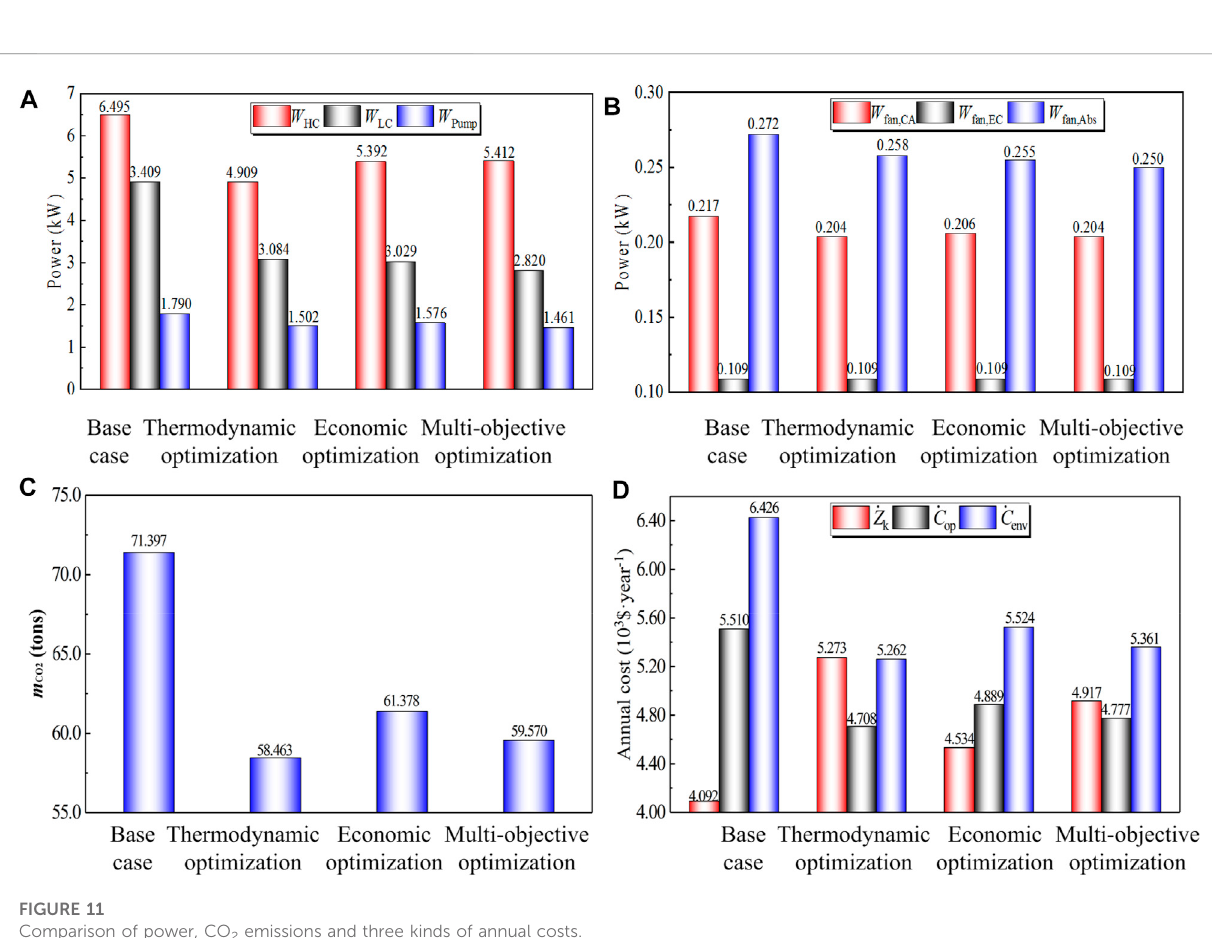
FIGURE 11 Comparison of power, CO 2 emissions and three kinds of annual